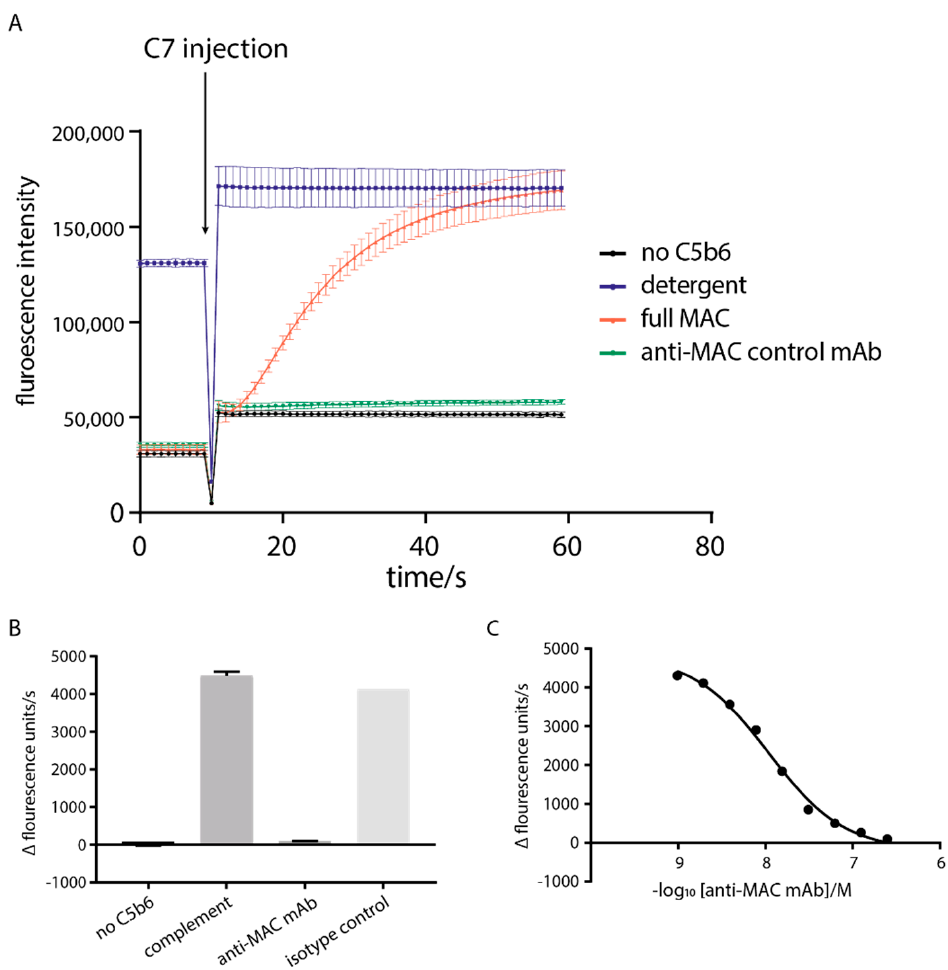
Figure 5. Development of functional complement assays. ( A ) Liposome leakage assay development. Fluorescence intensity measured kinetically and C7 injection time point indicated. The assay was run using full MAC (red), a no − C5b6 low control (black), full MAC plus detergent high control (blue) and full MAC plus an anti-MAC tool antibody (green). ( B ) Liposome assay development using an anti-C7 mAb was used anti-MAC positive control antibody and an isotype control antibody. ( C ) Dose − dependent effect of the anti − MAC antibody on the kinetics of liposome formation.